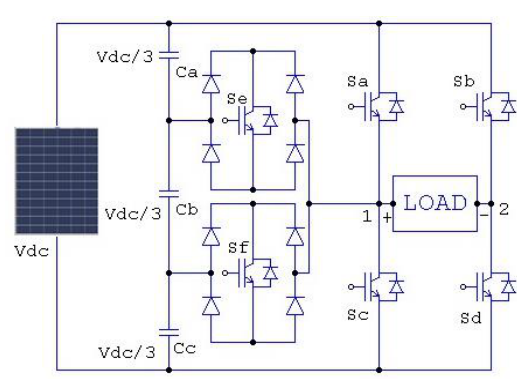
Figure 6. Seven Level MLI for